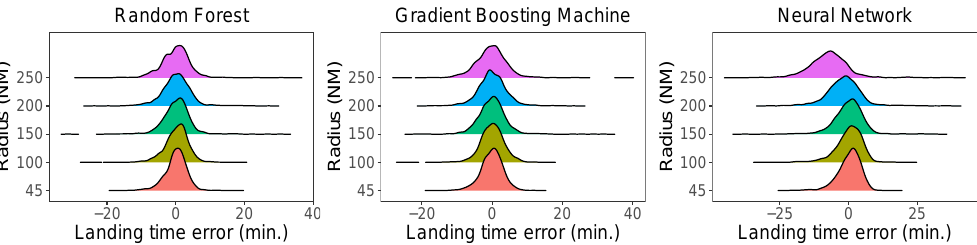
Figure 8. Density plot of errors on the test set depending on the radius by the RF, GBM, and NN